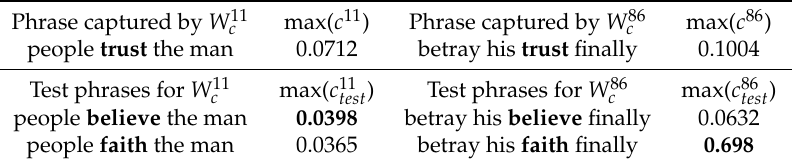
Table 5. Case study of Convolution Filtering Weights of